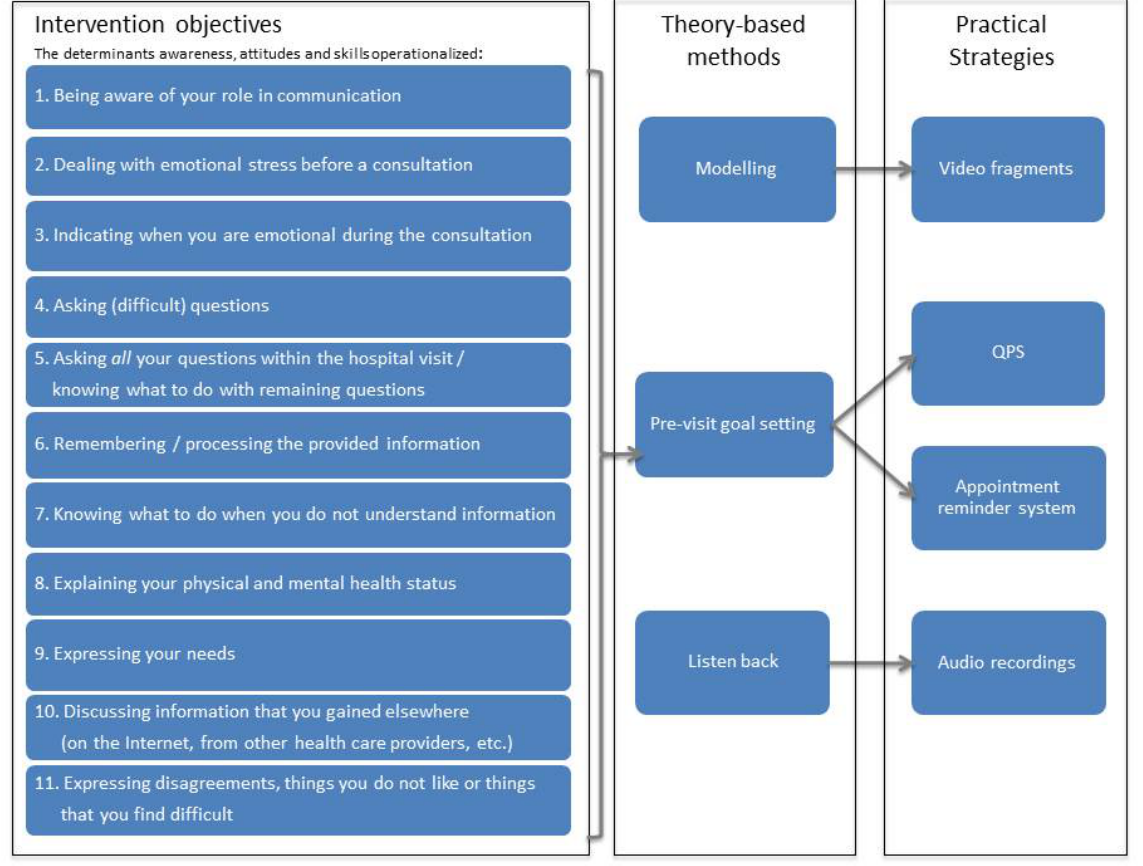
Figure 3. Intervention objectives, theory-based methods, and practical